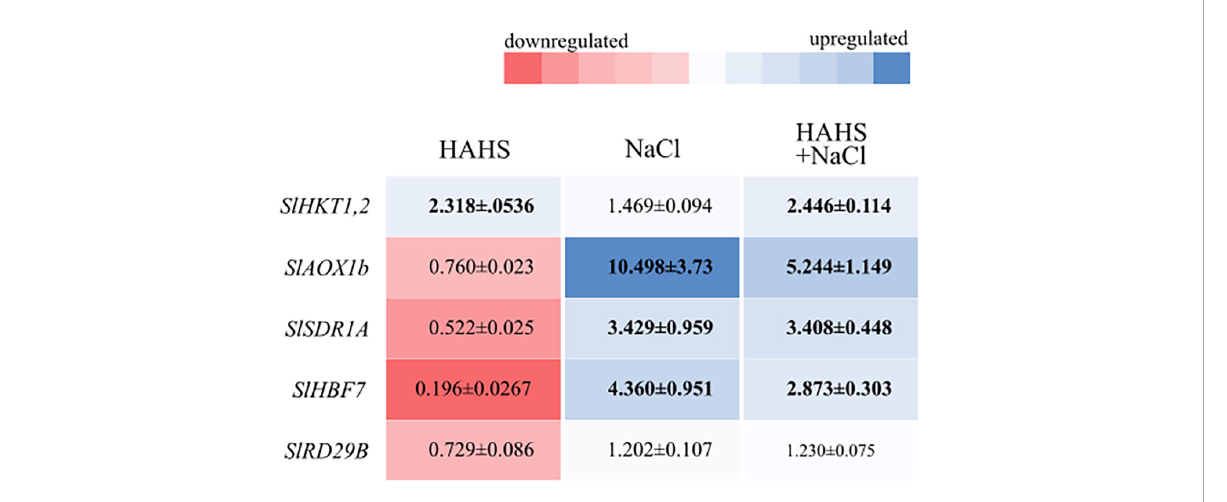
FIGURE7 Salinispora arenicola modulates the expression of saline response genes in tomato plant leaves. Shade plot showing up- (blue) or downregulated (red) saline responsive genes in plants in the habitat-adapted heterologous symbiont (HAHS), HAHS + NaCl, and NaCl treatments. Gene expression was normalized to control expression. Black numbers inside the colored blocks indicate changes in expression at least 50% lower or higher than that of the